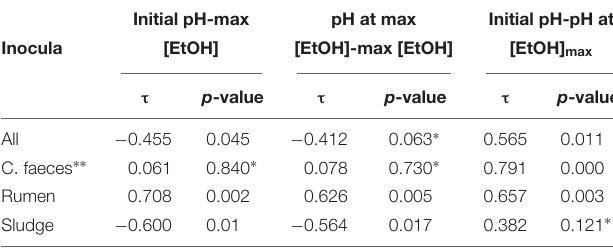
TABLE 2 | Correlation analysis results of maximal EtOH production, initial pH, and pH at maximal EtOH concentration. Initial pH-max pH at max Initial pH-pH at